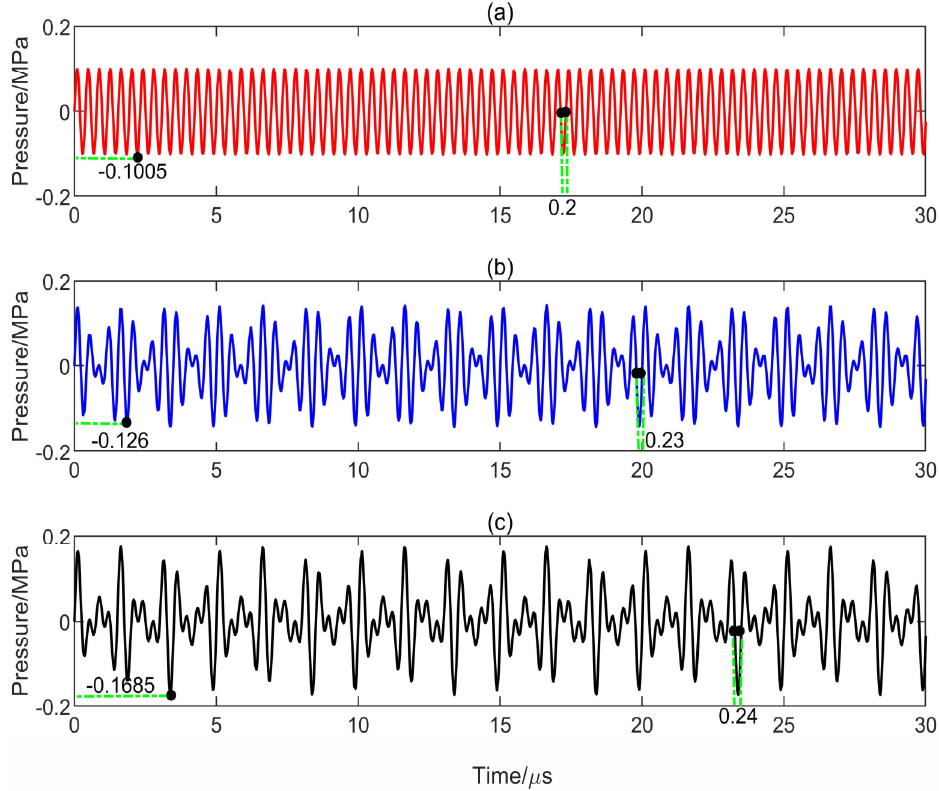
Figure4. Pressurewaveformsofdi ff erentfrequencycombinationsinliver: ( a )2.6MHz; ( b )2.6 + 2.0MHz; ( c ) 2.6 + 2.0 + 1.4 Figure 4. Pressure waveforms of different frequency combinations in liver: ( a ) 2.6 MHz; ( b ) 2.6 + 2.0 MHz; ( c ) 2.6 + 2.0 + 1.4 MHz.